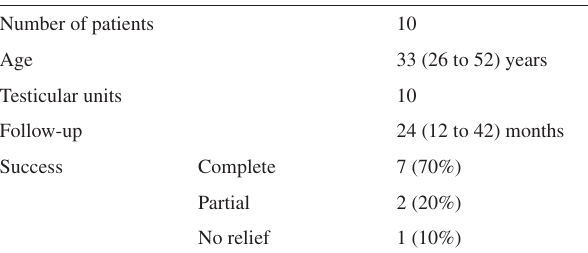
Table 1. Surgically treated patients Number of patients Testicular